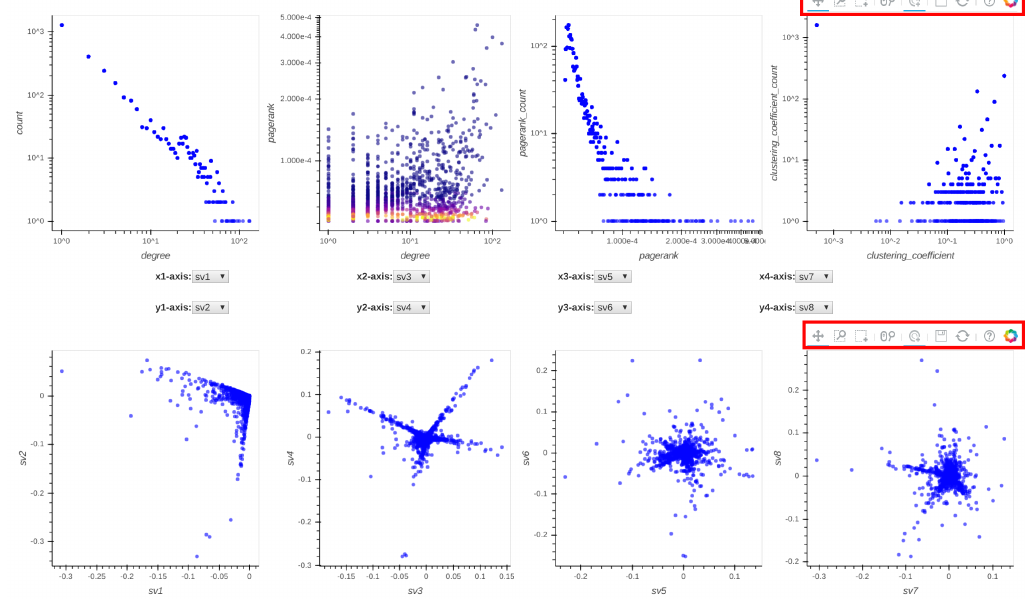
Figure 4. Layout of the graphs displayed in the frontend. The plots in the first row are degree vs. count, degree vs. PageRank, PageRank vs. PageRank count and ClusteringCoefficient vs. ClusteringCoefficient count. The plots in the second row are singular vector (sv) relationships, specifically they are sv1 vs. sv2, sv3 vs. sv4, sv5 vs. sv6, sv7 vs. sv8. Note that each node in the degree vs. PageRank plot is colored according to the PageRank count value of each node, a high count is red and a low count is blue. The red box annotations indicate the Bohek toolbar.